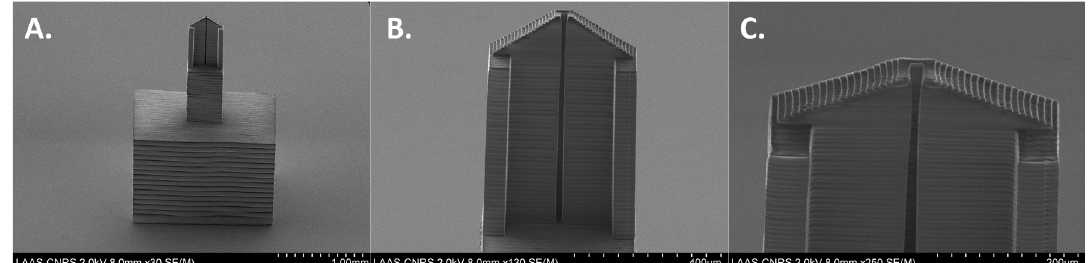
Figure 1. Scanning Electron Microscopy (SEM) pictures of a polymeric microcantilever used to perform the antibodies immobilization at different magnifications. (See electronic Supplementary Materials for more information on its conception).